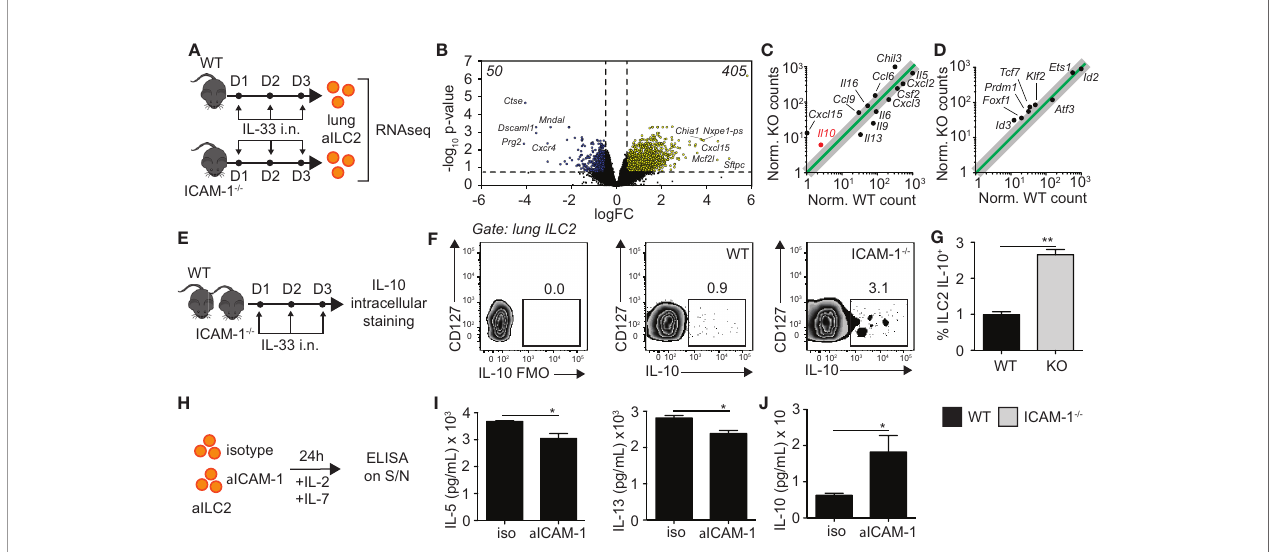
FIGURE 6 | ICAM-1 on ILC2s controls ILC2 effector functions. (A) Cohorts of C57BL/6 (WT) and ICAM-1 − / − mice were challenged intranasally on days 1 to 3 with 0.5 µg rmIL-33. On day 4, lungs were recovered, processed to single cell suspensions, and pulmonary activated ILC2s (gated as CD45 + Lin − ST2 + CD127 + ) were FACS-sorted to a purity of >95%. Sorted lung activated ILC2s (aILC2s) were directly lysed to perform RNAseq analysis. Shown in (B – D) are the results from a 2 vs 2 comparison, with each sample being a lung aILC2 pool of 4 mice. (B) Volcano plot comparison depicting the expression of >13,000 transcripts detected in WT and ICAM-1 − / − lung aILC2s by the analysis. Differentially downregulated or upregulated genes (adj. p < 0.05 and 2-fold change cutoff) are presented in blue and yellow, respectively, with their respective numbers indicated in both upper corners of the plot. (C, D) Linear plot comparisons of WT and ICAM-1 − / − lung ILC2s depicting the expression of (C) cytokines and chemokines and (D) IL-10-producing ILC2 transcription factors based on a previous publication (26). Adjusted p-values: Il10 = 0.048, Cxcl15 = 0.002, Il13 = 0.005, Il9 = 0.024, Il6 = 0.049, Il5 = 0.004, Csf2 = 0.049, Cxcl2 = 0.004, Cxcl3 = 0.048, Il16 = 0.035, Ccl6 = 0.015, Ccl9 = 0.017, Chil3 = 0.008, Foxf1 = 0.049, Id3 = 0.006, Klf2 = 0.018, Prdm1 = 0.026, and Tcf7 = 0.010. (E) Cohorts of C57BL/6 (WT) and ICAM-1 − / − mice were challenged intranasally on days 1-3 with 0.5µg rmIL-33. On day 4, lungs were recovered and processed to single cell suspensions. After processing, lung cells were further stimulated with PMA, ionomycin and Brefeldin A for 4 h at 37°C prior staining for IL-10 intracellular cytokine marker. (F) Representative fl ow cytometry plots of intracellular IL-10 expression within total lung ILC2s of WT and LFA-1 − / − (gated as CD45 + Lin − Thy1.2 + ST2 + CD127 + ) and (G) corresponding quantitation presented as mean frequency of IL-10 – producing lung ILC2s in each cohort ± SEM. FMO: Full Minus One staining control. (H) BALB/cByJ mice were challenged intranasally on days 1 to 3 with 0.5 µg rmIL-33. On day 4, lungs were recovered, processed to single cell suspensions, and pulmonary activated ILC2s (gated as CD45 + Lin − ST2 + CD127 + ) were FACS-sorted to a purity of >95%. Sorted lung aILC2s were then cultured in vitro (50 × 10 4 /ml) for 48 h with rmIL-2 (10 ng/ml), rmIL-7 (10 ng/ml) with or without anti-ICAM-1 (10 µg/ml). Culture supernatants were recovered for cytokine analysis by ELISA. (I) Levels of IL-5 and IL-13 in culture supernatants measured by ELISA. (J) Levels of IL-10 in culture supernatants measured by ELISA. Data are representative of 3 individual experiments with n = 5 except for RNAseq. *p < 0.05, **p <